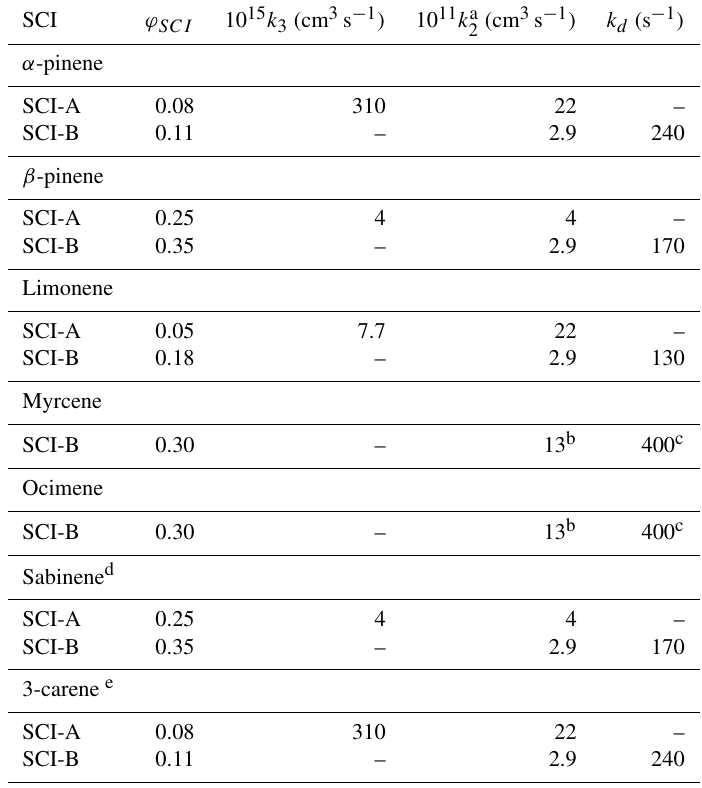
Table 5. Kinetic parameters used in the global modelling